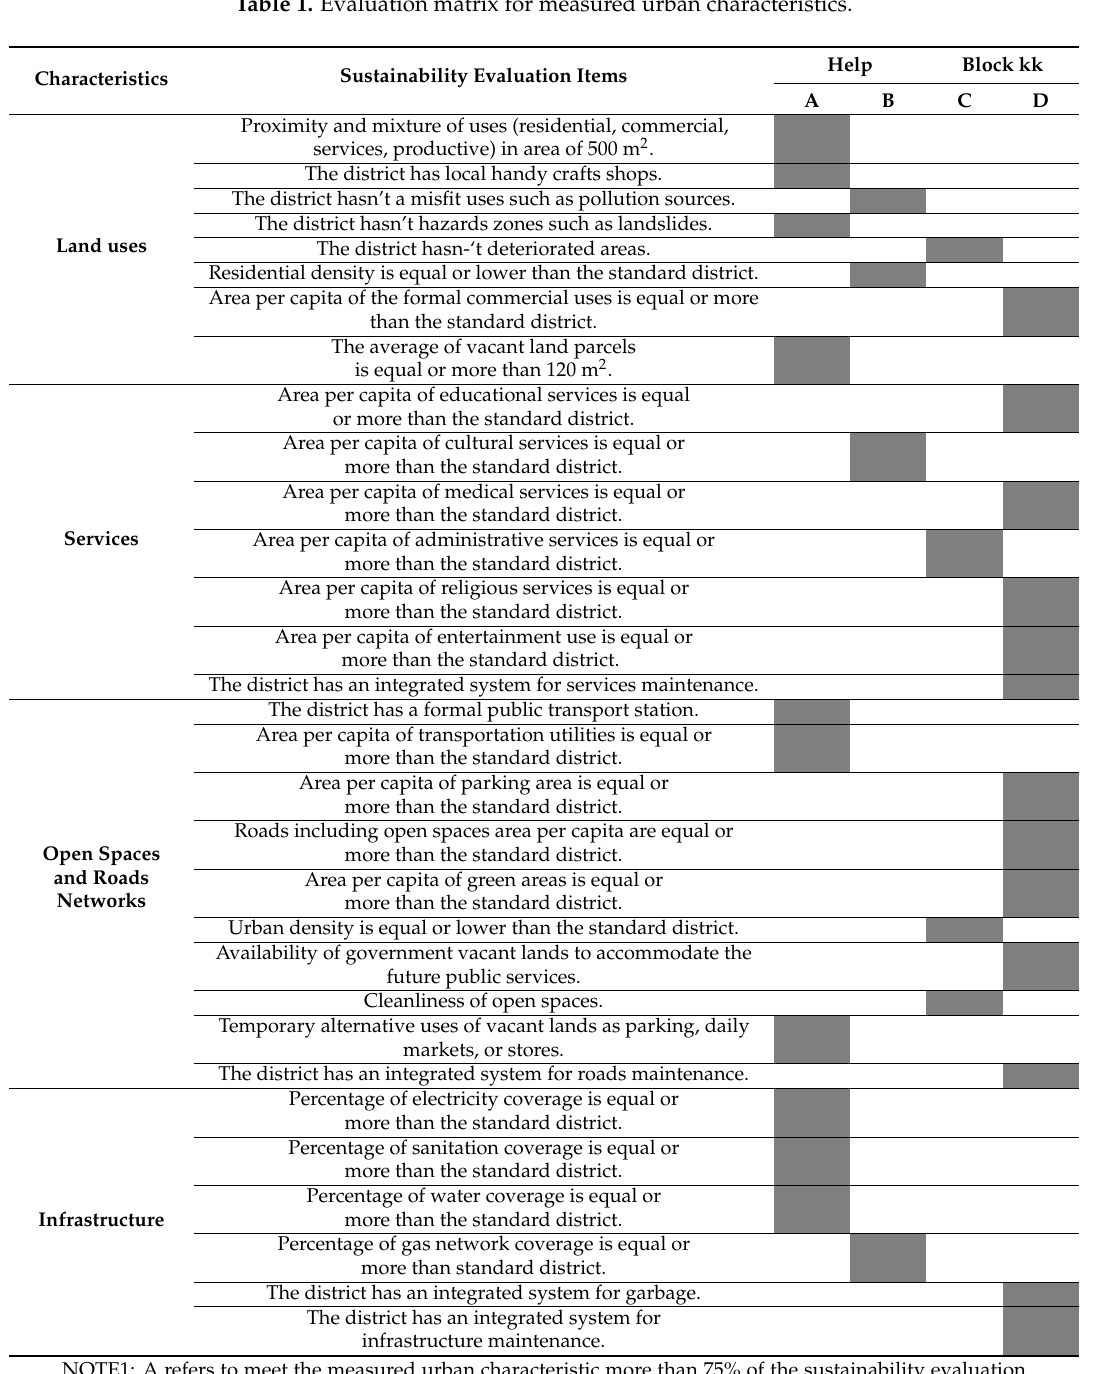
Table 1. Evaluation matrix for measured urban